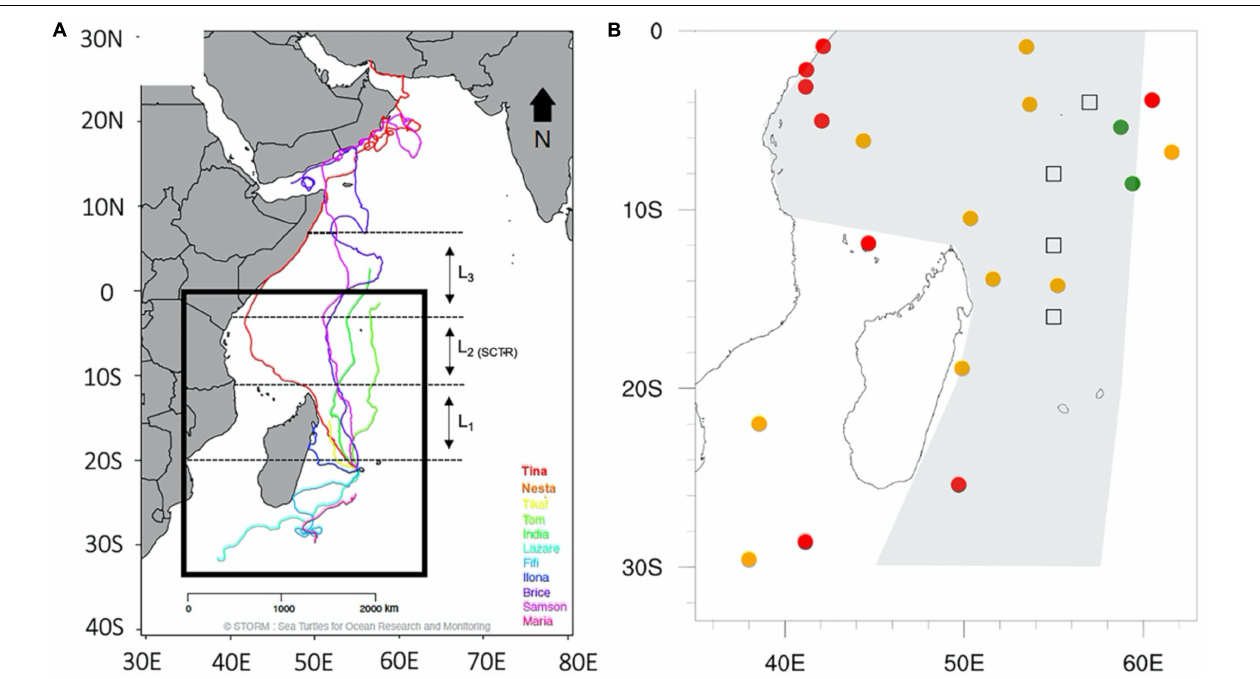
FIGURE 2 | (A) Tracks of the 11 sea turtles equipped between Jan 2019 and March 2020 during the preliminary phase of the STORM project as of 30 April 2020. (B) Location of Argo drifters (circles) and RAMA moored buoys (squares) deployed in the area (35–63 ◦ E; 0–33 ◦ S) as of 23 April 2020. Green, orange and red colors indicate drifters that have transmitted data in the last 3, 10, and 30+ days, respectively. In (B) the gray shaded area shows the spatial distribution of the 20 loggerhead ST tracked from Reunion island during the COCA-LOCA project (Dalleau et al., 2014). Dashed black lines in (A) show latitude bands LB1 [11 ◦ S–20 ◦ S],